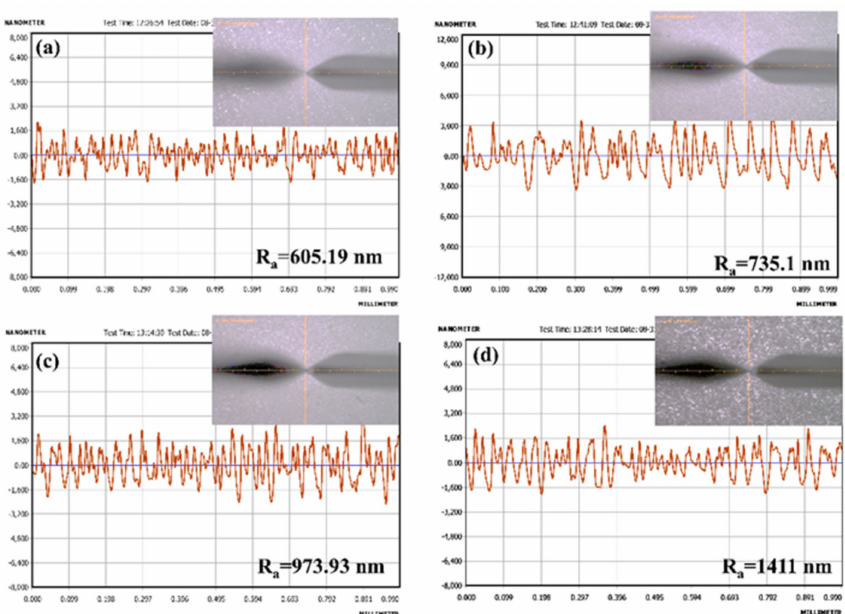
Figure 7. Microscope images and profilometric histogram of polyurethane-based composite mem- branes prepared in wet conditions with different amounts of IONPs: ( a ) 0%, ( b ) 0.1%, ( c ) 0.5%, and ( d )